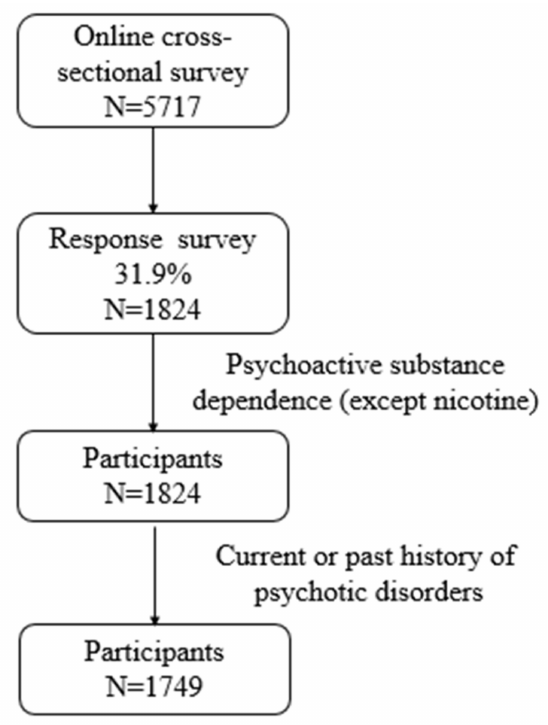
Figure 1. Flowchart of the selection of study